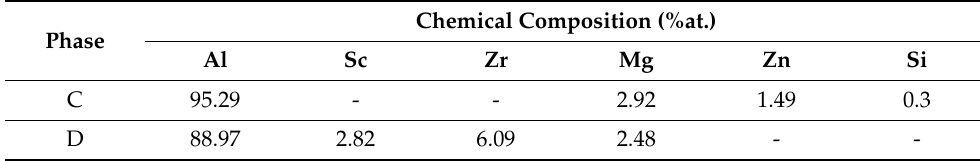
Table 5. EDS analysis of points C and D in Figure 9.